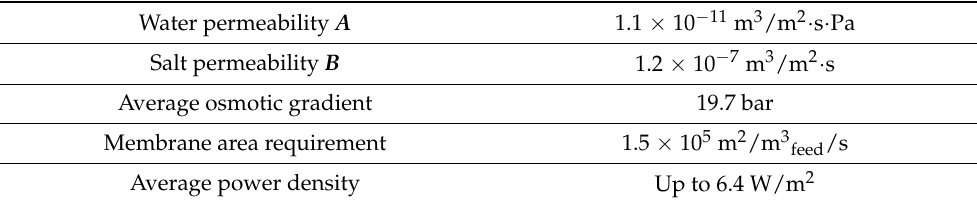
Table 2. Membrane parameters, operation variables and performance